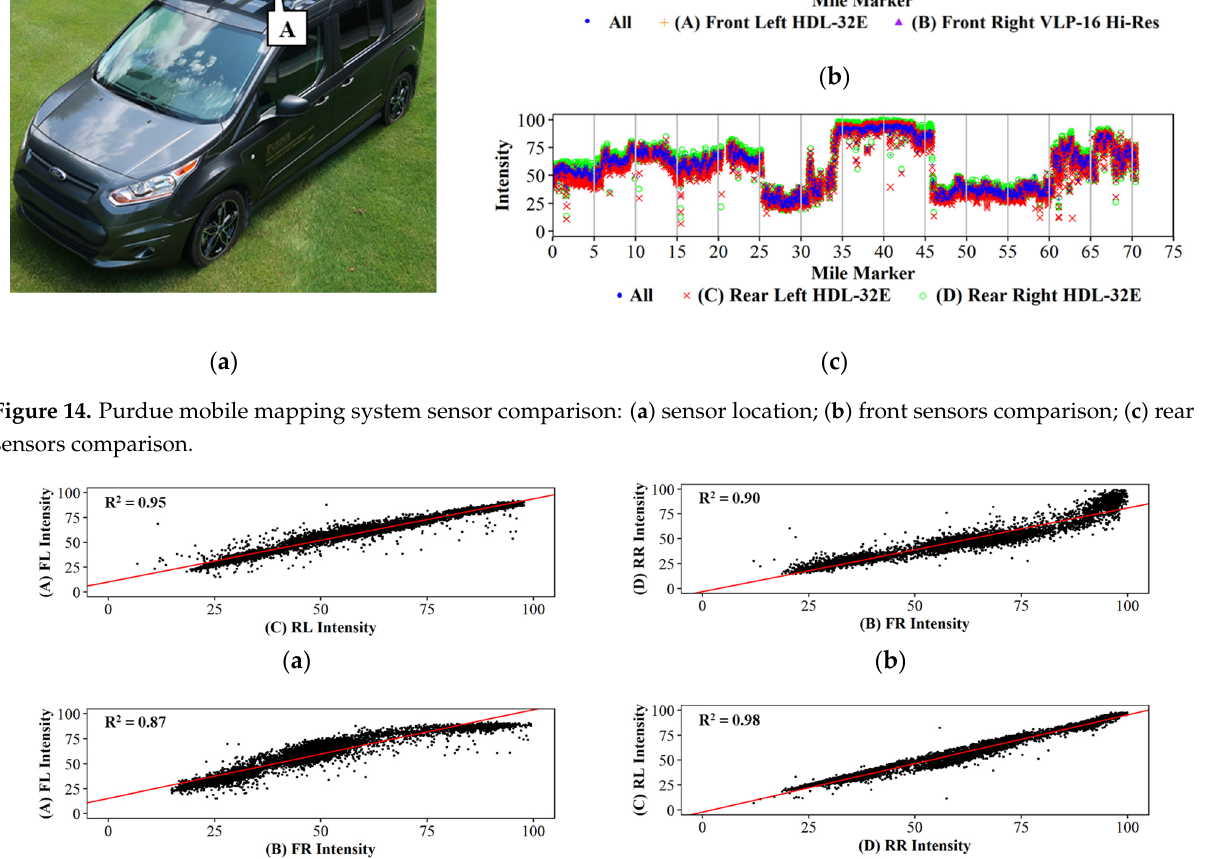
Figure 15. Linear correlation between different sensors on Purdue mobile mapping system: ( a ) rear left HDL-32E linear